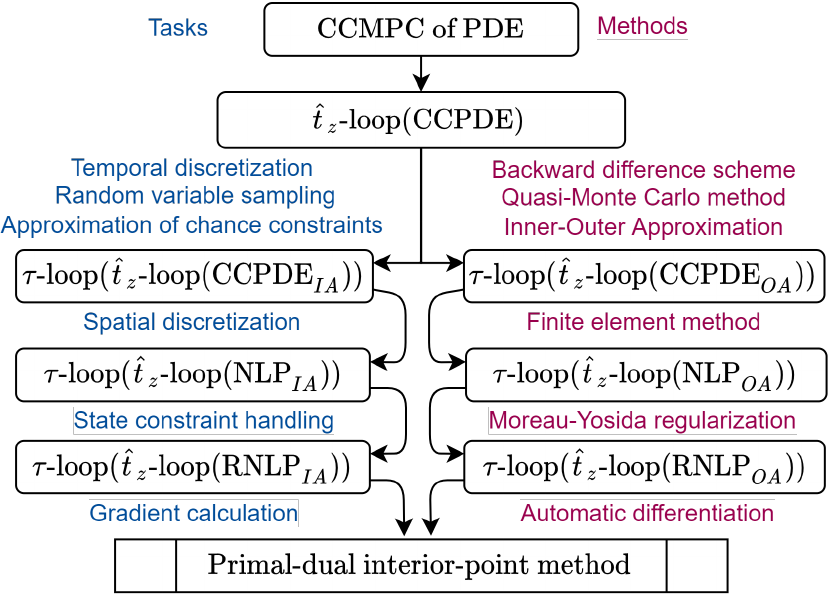
Figure 2. Implementation flow